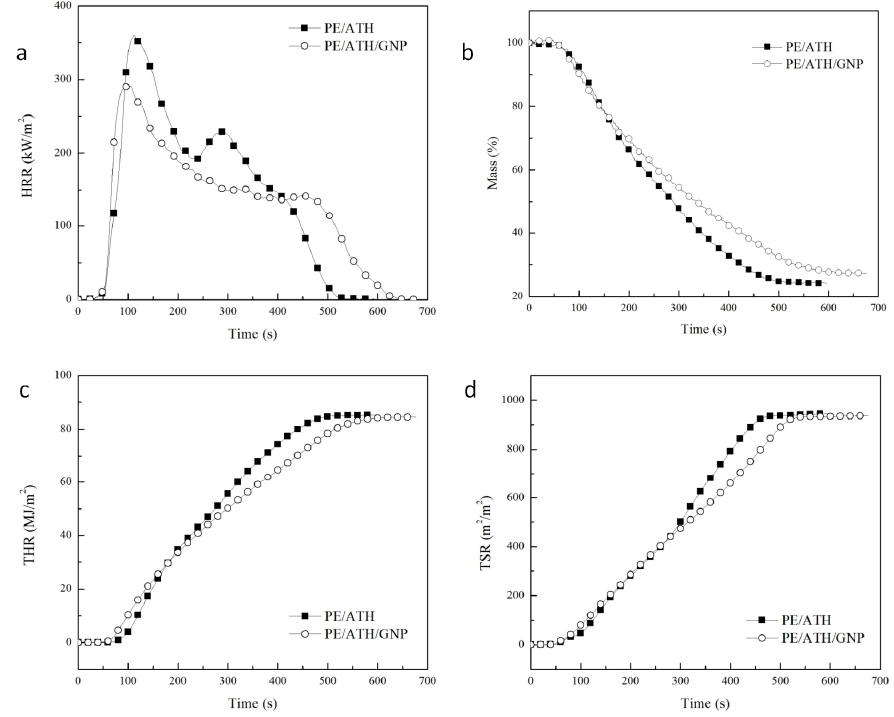
Figure 6. ( a ) HRR, ( b ) Mass, ( c ) THR and ( d ) TSR curves of PE/ATH and PE/ATH/GNP by Cone testing.